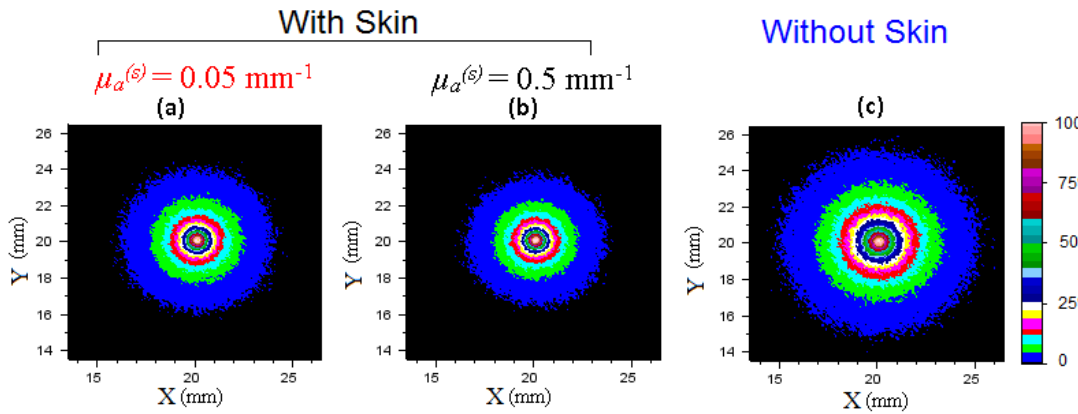
Figure 3. Simulated backscattering images captured at the periphery of a whole apple with skin ( a), (b ), and without skin ( c ). The images were generated with µ a ( f ) = 0.015 mm −1 - µ ’ s ( f ) = 1.15 mm −1 , and ( a ) µ a ( s ) = 0.05 mm −1 - µ ’ s ( s ) = 4 mm −1 , ( b ) µ a ( s ) = 0.5 mm −1 - µ ’ s ( s ) = 4 mm −1 , ( c ) µ a ( s ) = µ a ( f ) - µ ’ s ( s ) = µ ’ s ( f ) , r s = 35 mm, skin thickness of 80 µm, and normalized with respect to their peak intensity.